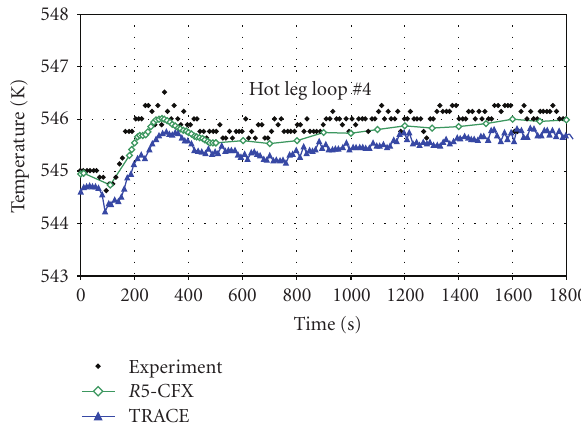
Figure 22: Comparison of the data with the predictions for loop